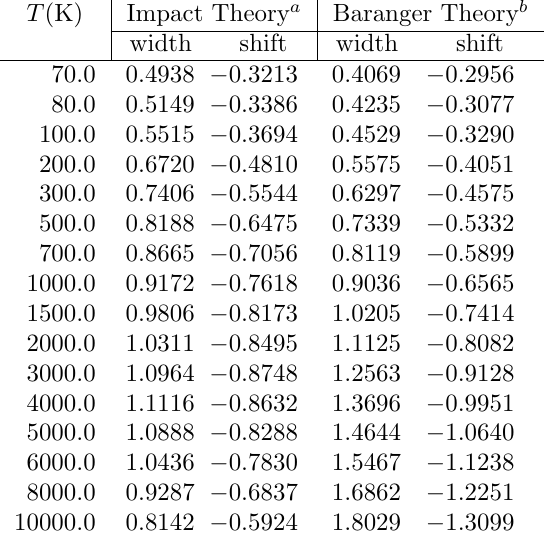
Table 9. Transition Ar 4s’( J = 1){5p’( J = 0) at 426.06 nm broadened by argon. Half half-widths w=N and shifts d=N (in units of 10 (cid:0) 21 MHz m 3 /atom = (2 (cid:25) ) (cid:0) 1 (cid:2) 10 (cid:0) 9 rad s (cid:0) 1 cm 3 /atom) a present work; b Peach